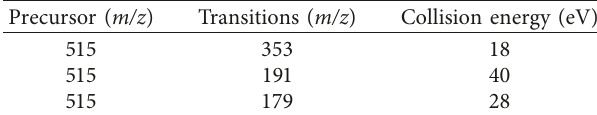
Table 1: MRM transitions automatically optimized using 3,5-diCQA. Precursor ( m/z